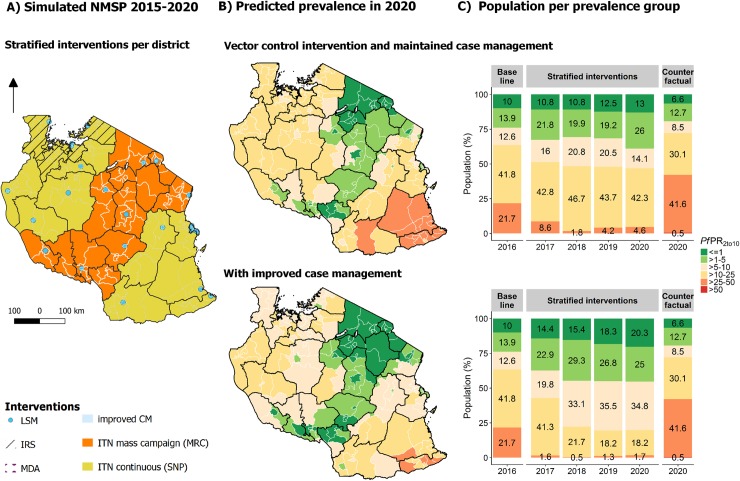
Strategy based on the NMSP 2015–2020 and simulated impact (Strategy 1).(A) Allocation of interventions per council, showing vector control interventions only. (B) Predicted prevalence per council in 2020 shown in the map and number of councils per simulated endemic group by year for 2017–2020 shown in the bar charts.